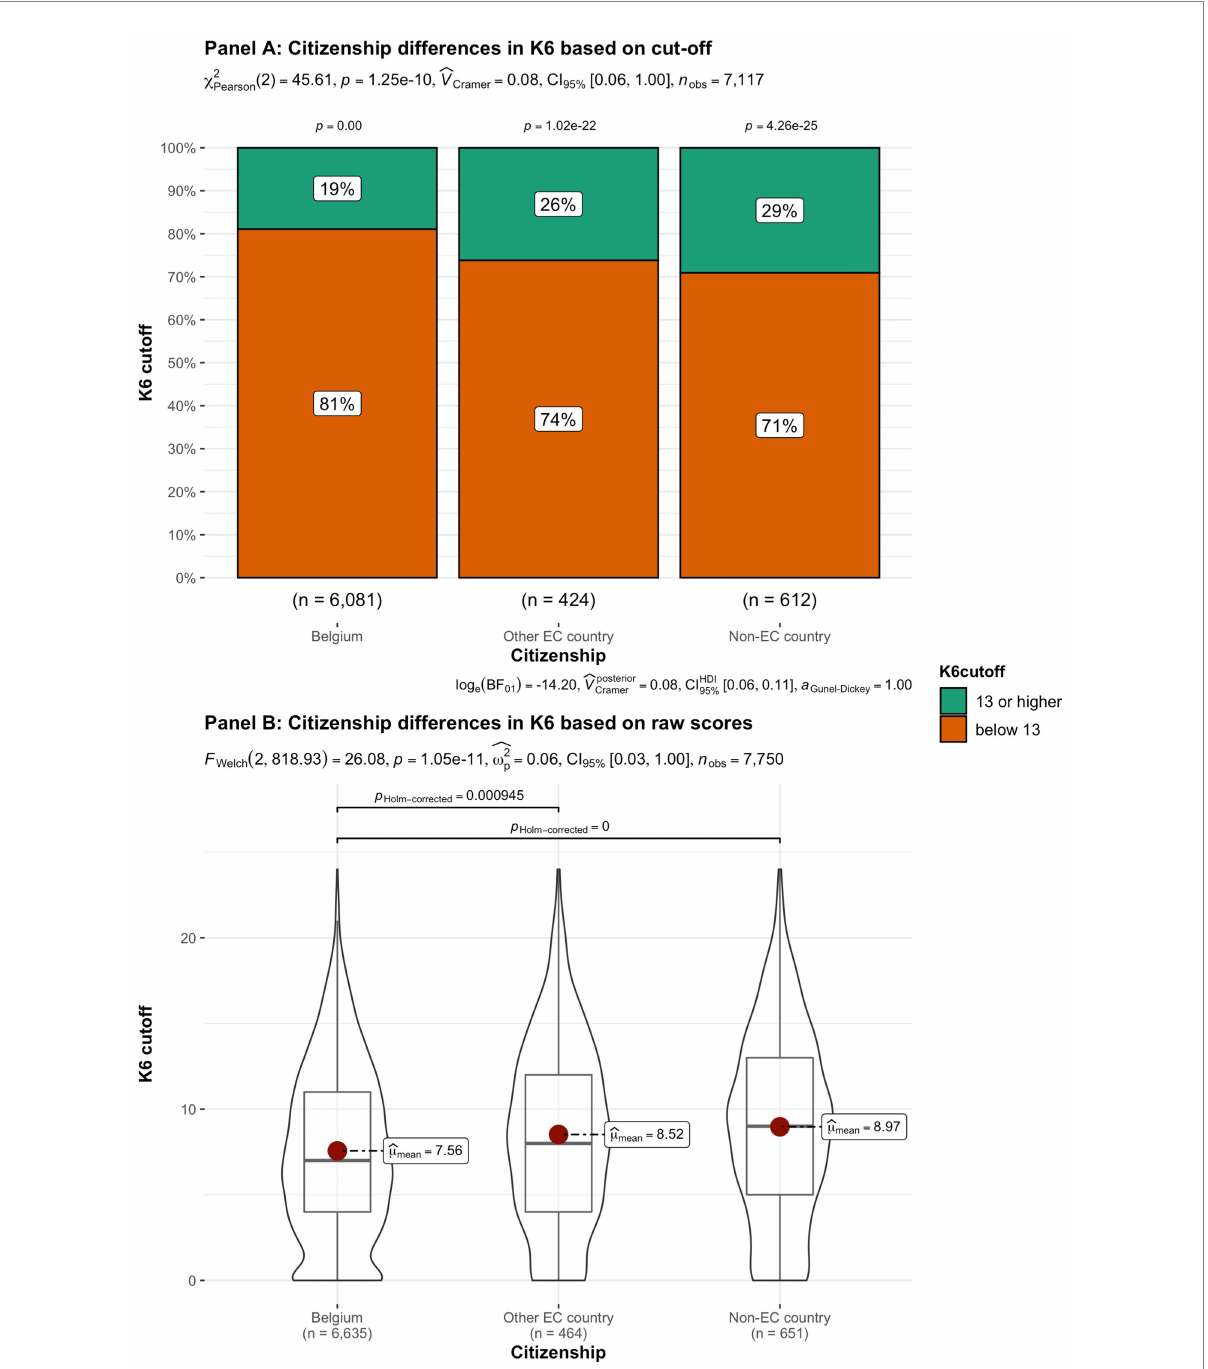
FIGURE 13 Summated scores on the K6 (indicator of mental illness and considered as a cutoff variable) across student subgroups in terms of